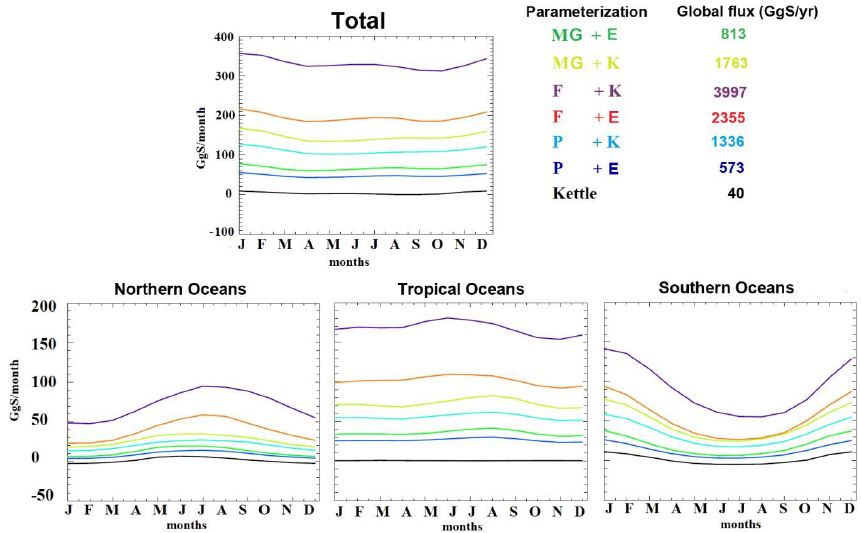
Figure 9. Global and regional monthly mean sea–air fluxes for six different parameterizations of the NEMO-PISCES model. Kettle et al. (2002) (black line) is shown as a reference. Each colored line represents a set of parameters: the first initial(s) refers to the equation used to calculate the UV absorption coefficient of CDOM at 350nm and the second initial refers to the hydrolysis constant formulation. Global fluxes on top row, northern oceans (30 ◦ –90 ◦ N, bottom left), tropical region (30 ◦ S–30 ◦ N, bottom center), southern oceans (30 ◦ –90 ◦ S, bottom right). F: a 350 relationship assembled in this study; MG: a 350 relationship from Morel and Gentili (2009); P: a 350 relationship from Preiswerk and Najjar (2000); E: hydrolysis constant from Elliott et al. (1989); K: hydrolysis constant from Kamyshny et al. (2003).